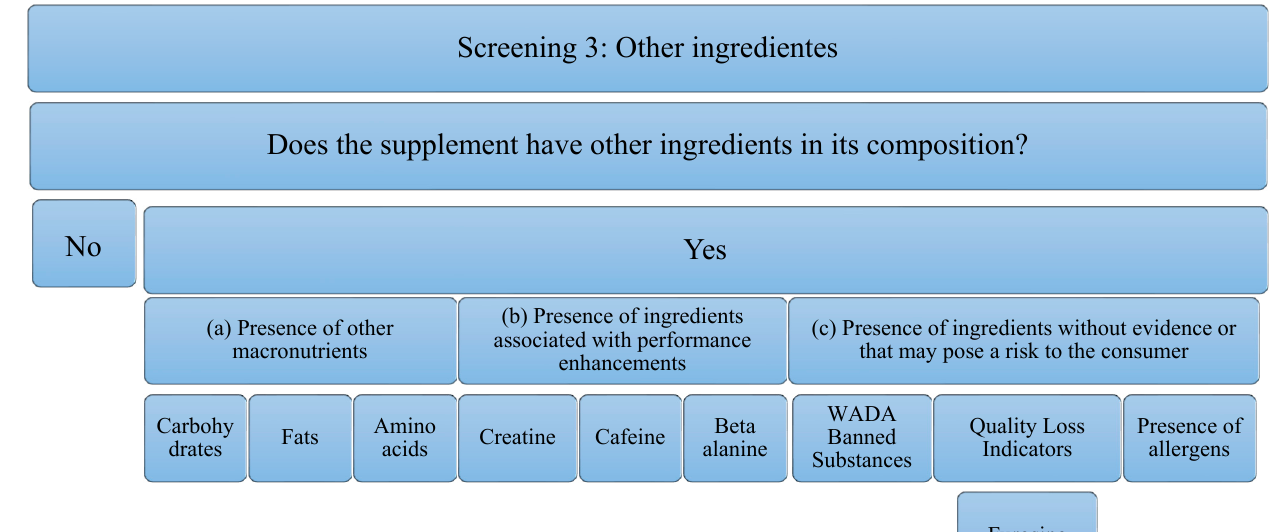
Figure 3. Flowchart Screening 3. Macronutrients, performance-enhancing ingredients, ingredients that have no proven impact on the consumer, and allergens are examined.